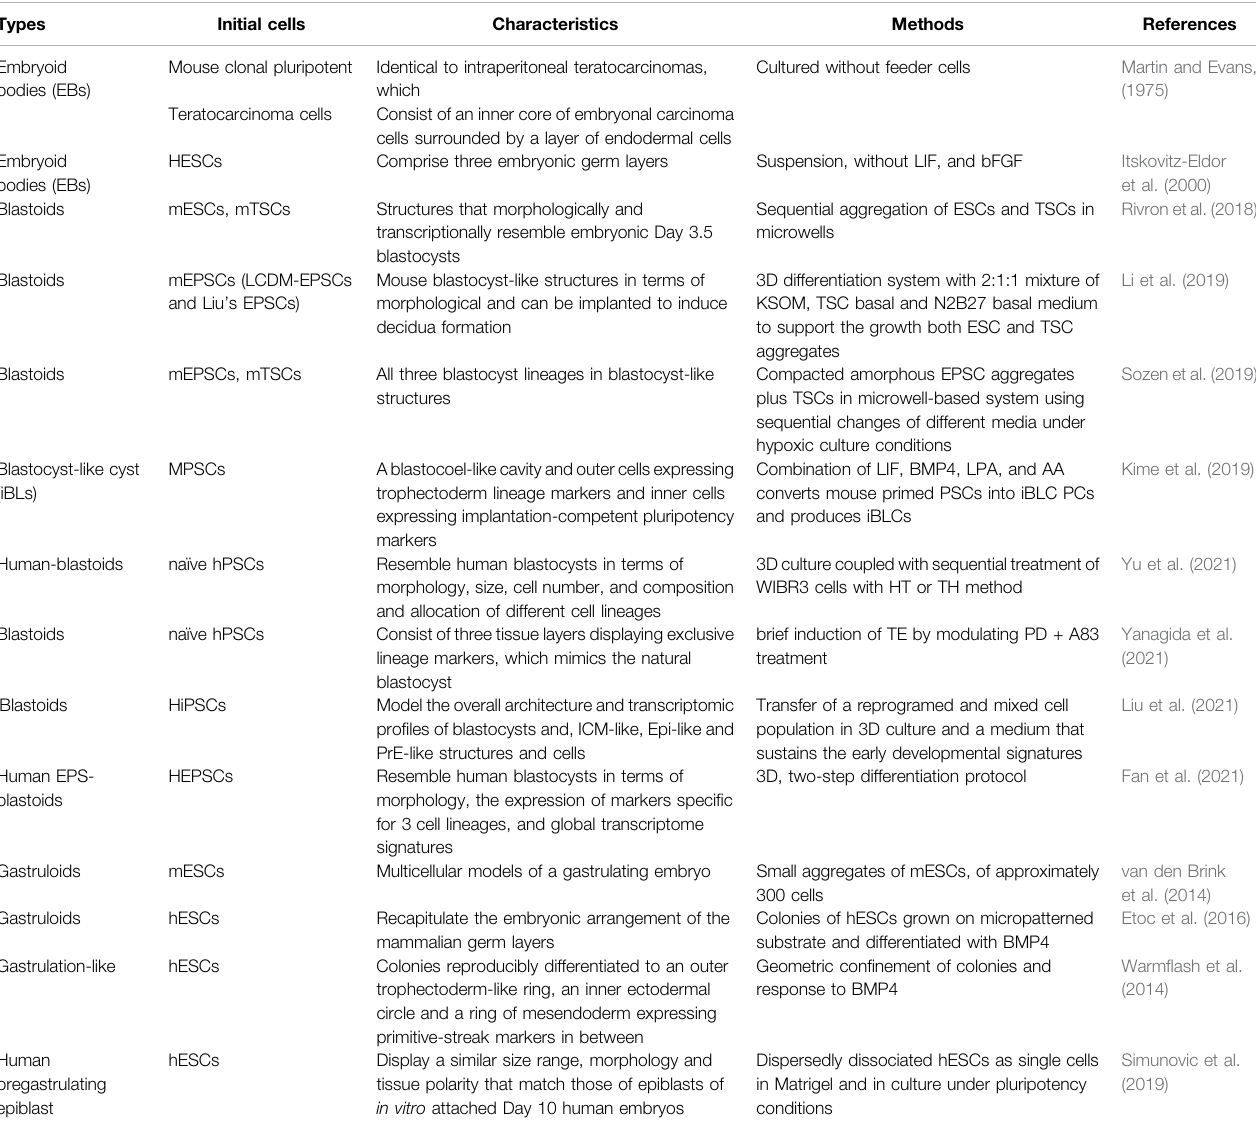
TABLE 1 | Embryoids and stem cell